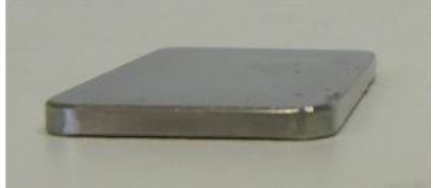
Figure 4. A typical SSC.